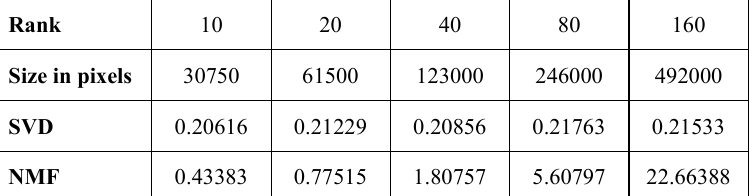
Table 7. Processing time (in second) of 512 × 512 pixel image.